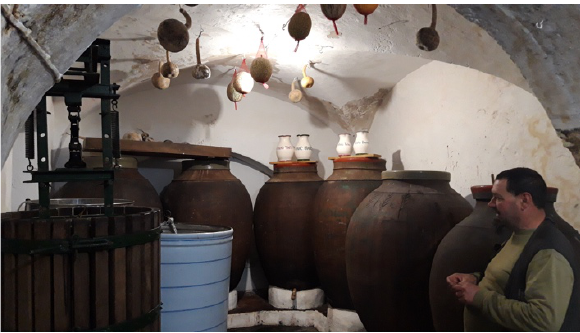
Figure 4. Wine clay recipients in a tavern. Rosado, 2020.